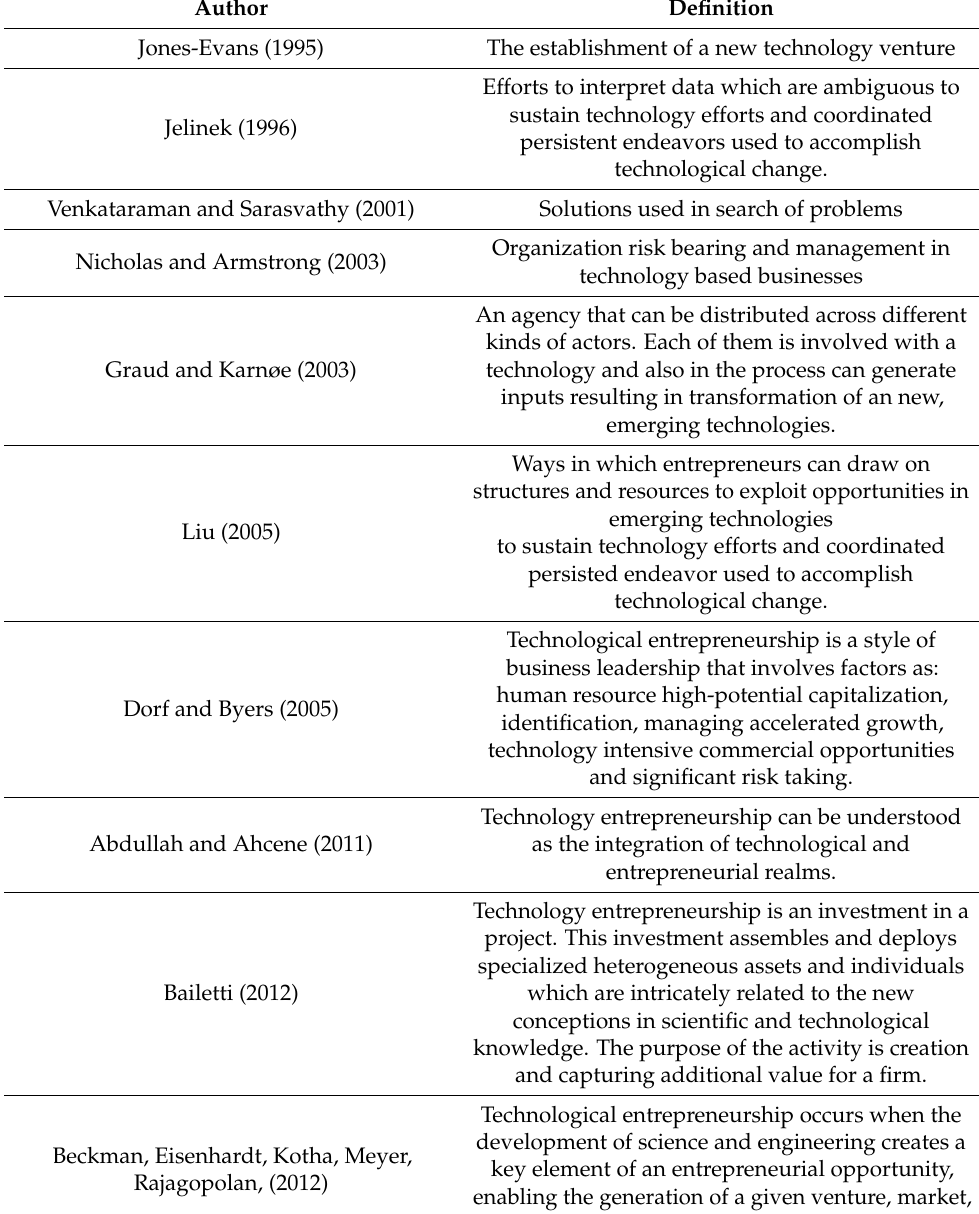
Table 1. The main definitions of technology